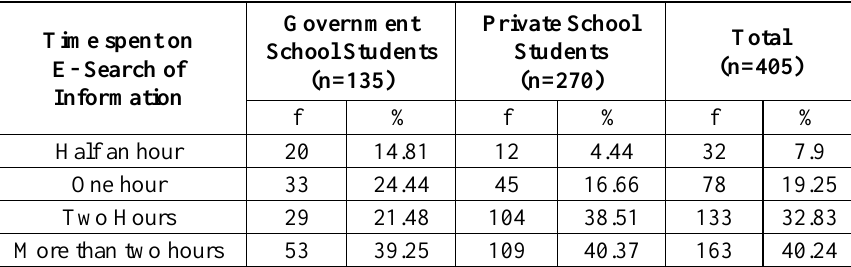
Time spent on E- Search